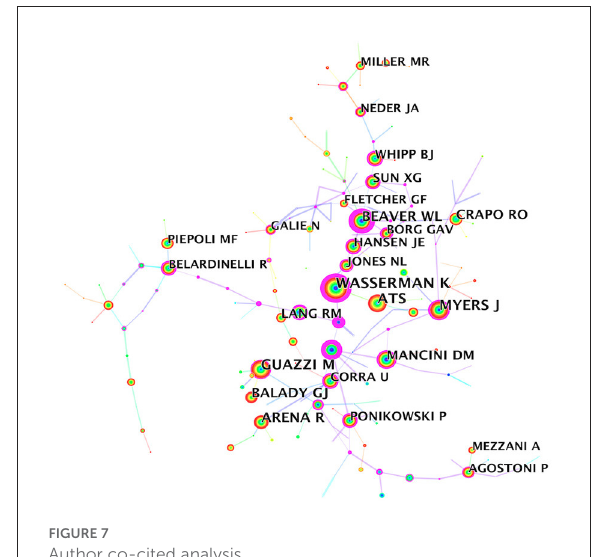
FIGURE7 Author co-cited analysis.